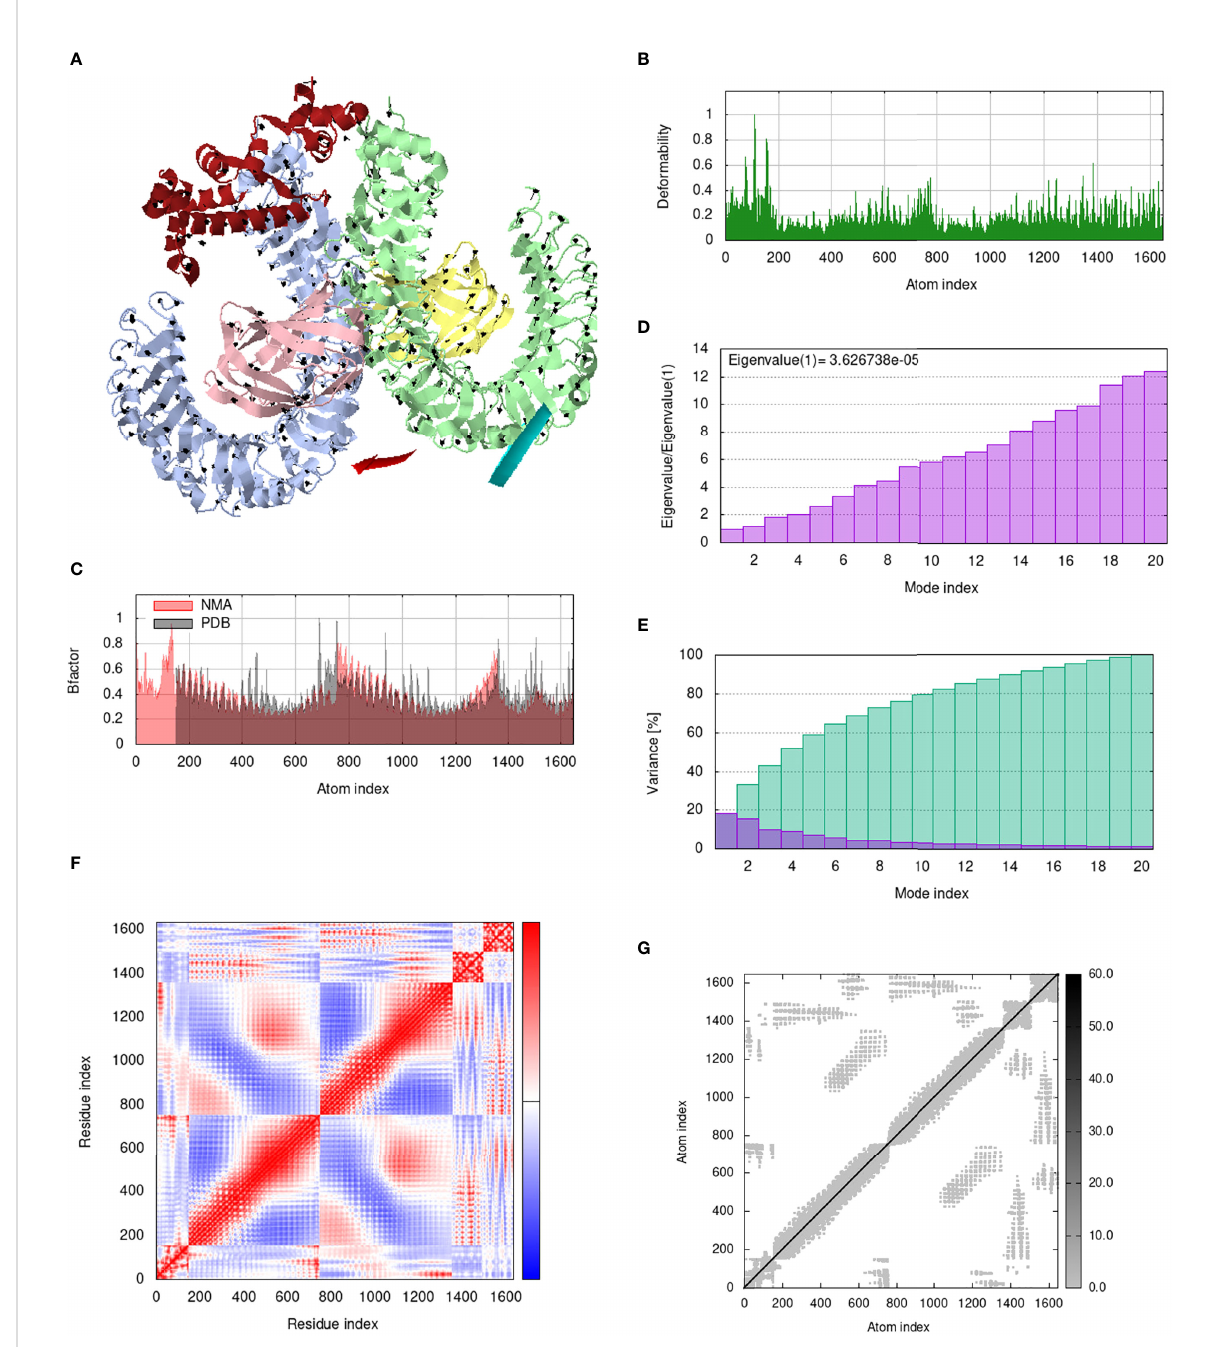
FIGURE 12 Analysis of the vaccine-TLR4 complex in normal mode. (A) Structural strength of the re fi ned protein-protein complex mobility; (B) deformability in relation to atoms; (C) B-factor in relation to atoms; (D) eigenvalue in relation to modes; (E) Structural variance; (F) covariance in relation to residue; (G) elastic network in relation to